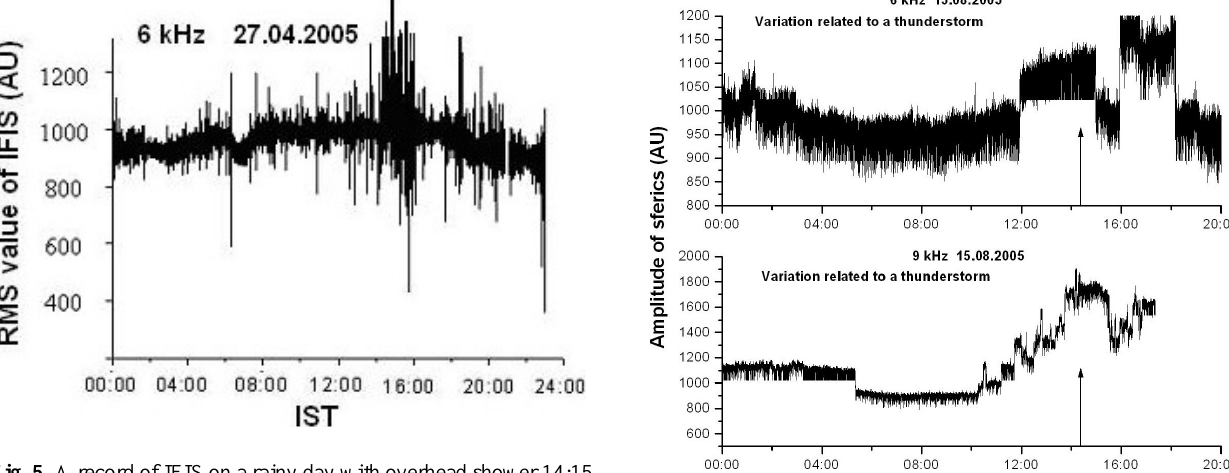
Fig. 5. A record of IFIS on a rainy day with overhead shower 14:15 to 16:05IST.